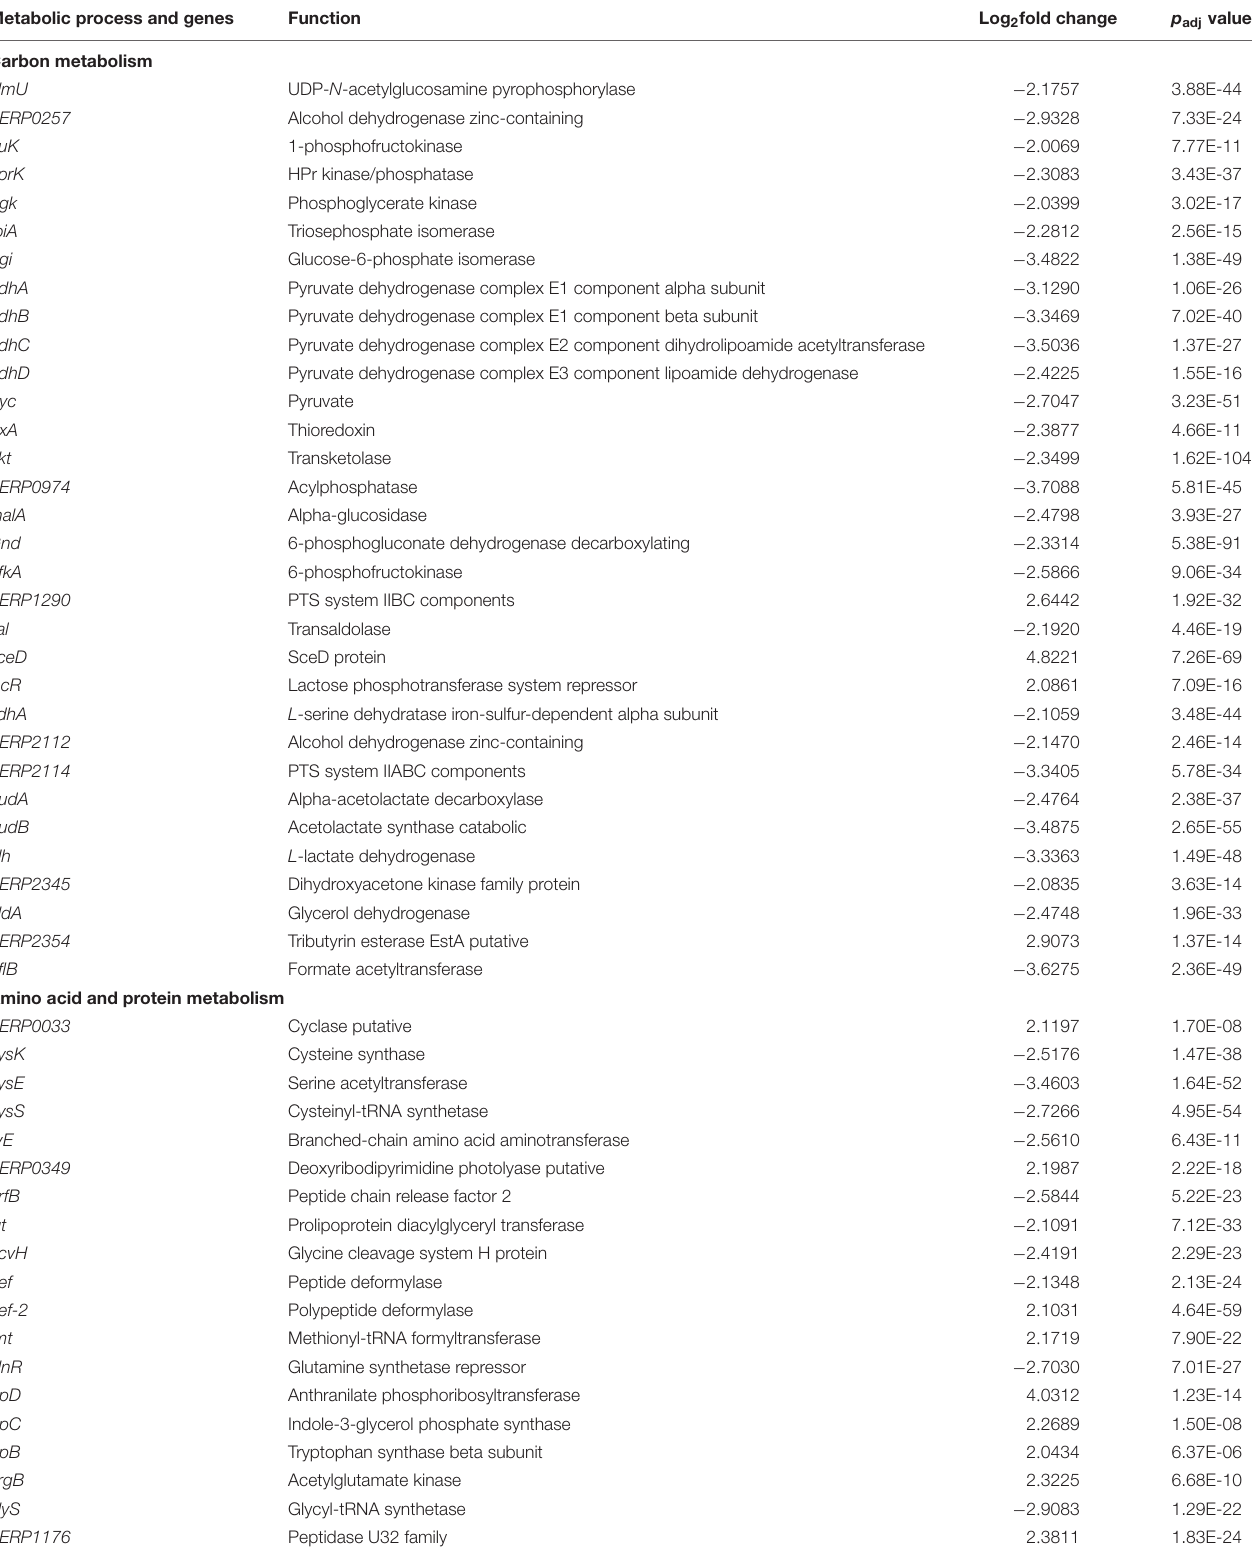
TABLE 4 | List of metabolism-related genes affected in response to SKC3 after 3 h. Metabolic process and genes Function Log 2 fold change p adj